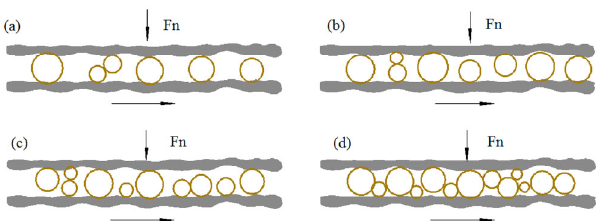
Fig. 14 The model shale rock-sand particles